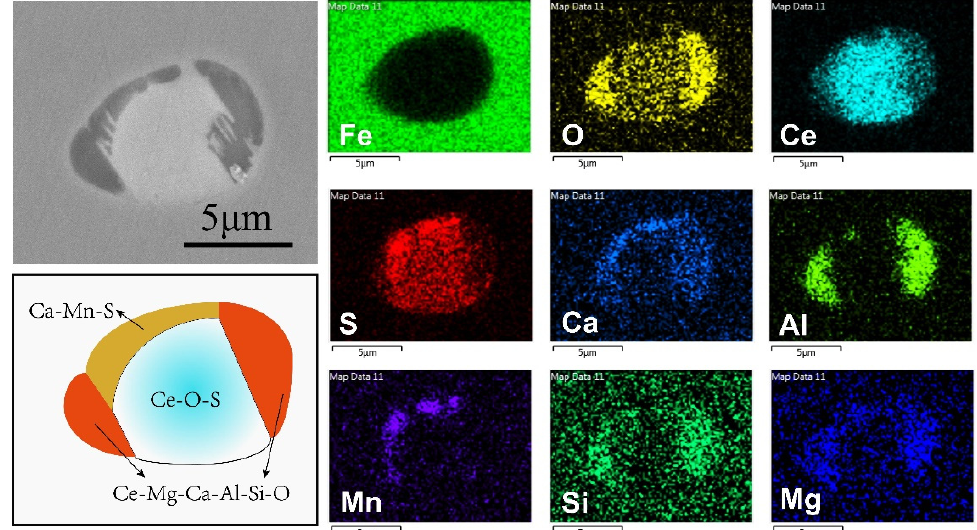
Figure 6. Typical elemental mapping of transition state inclusion in S1 sample for experiments A–C.